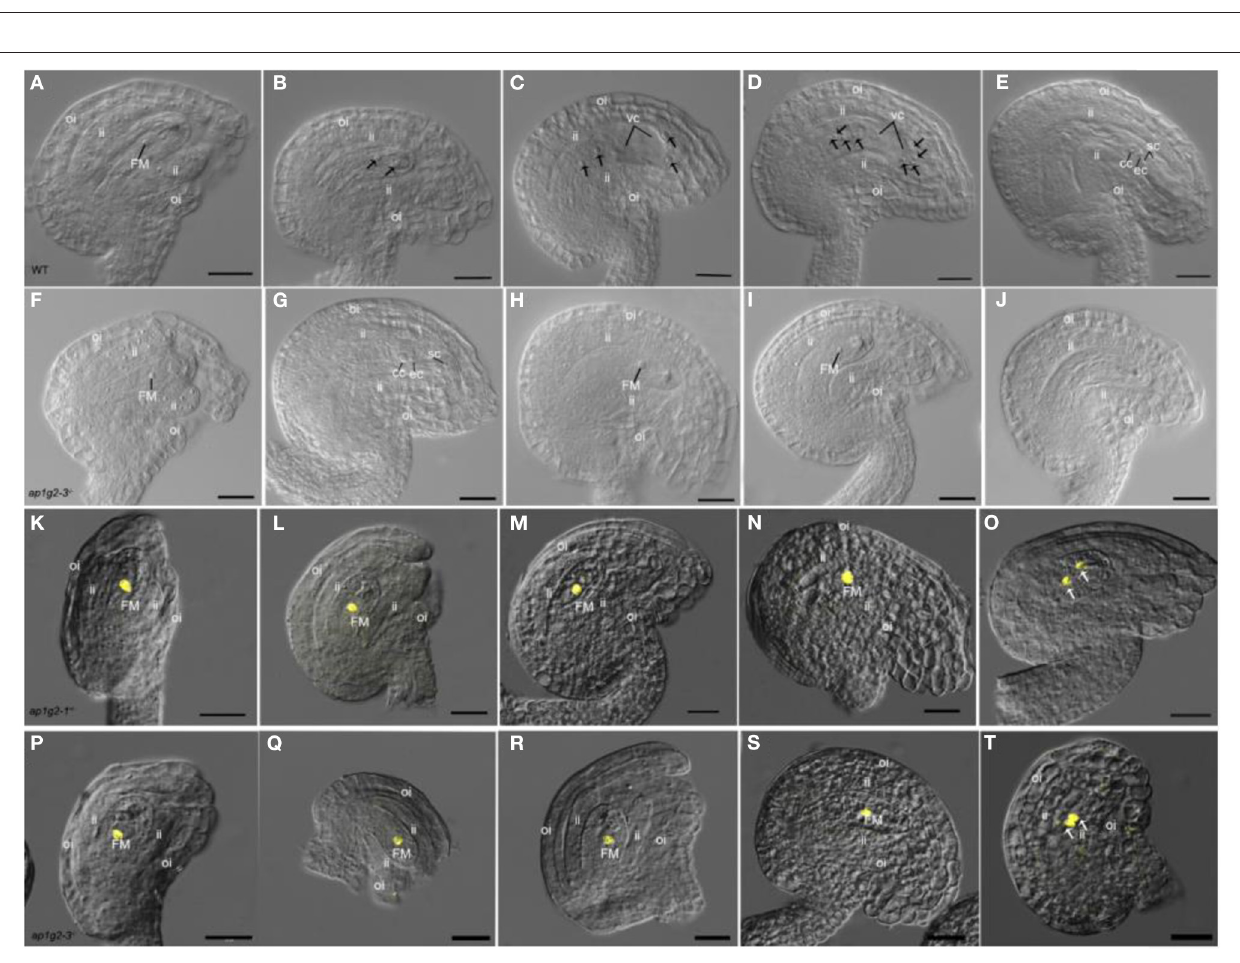
FIGURE 1 | the positions of the various T-DNA insertions ( ap1g2-1 and ap1g2-3 ) and the EMS mutant harboring a G-to-A base change at nucleotide position 8444076 ( ap1g2-4 ). The seed set of ap1g2-1 + / − , ap1g2-3 − / − , apg2-1/apg2-3 mutants was significantly lower than that of wild-type plants and the genetic complementation lines of ap1g2-1 + / − and ap1g2-3 − / − . (F) AP1G2 driven by its native promoter could partially complement the infertility phenotype of ap1g2-4 , but the seeds of transgenic plants had no heavy seed coat. Error bars indicate standard error. The capital letters above the bars mean very significant difference with the